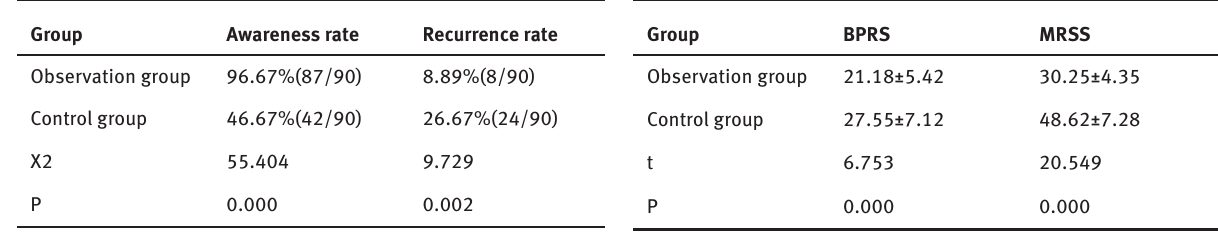
Table 2: Disease awareness and recurrence rate of the two groups 6 months after discharge [(n, %), n = 90]